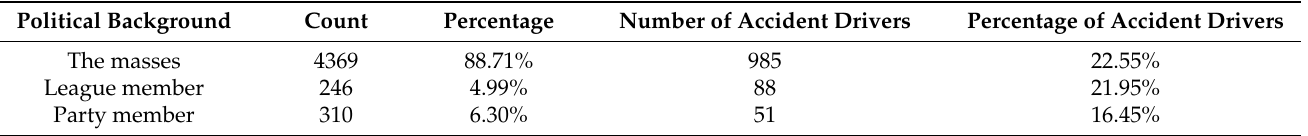
Table 7. Political background distribution.